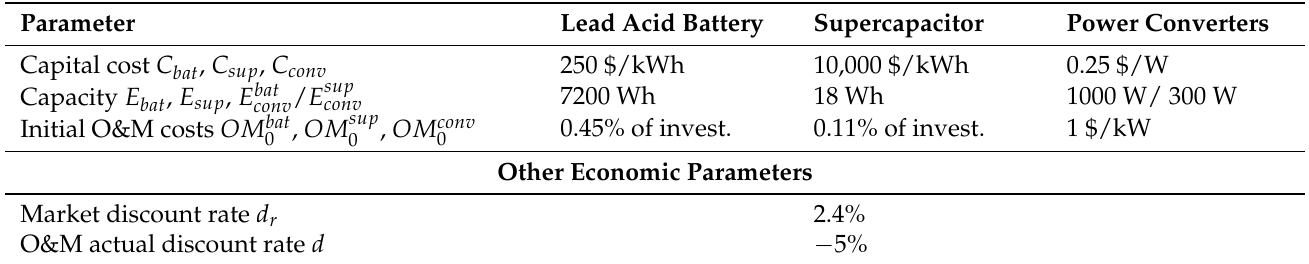
Table 5. Economic parameters [21,68,69].